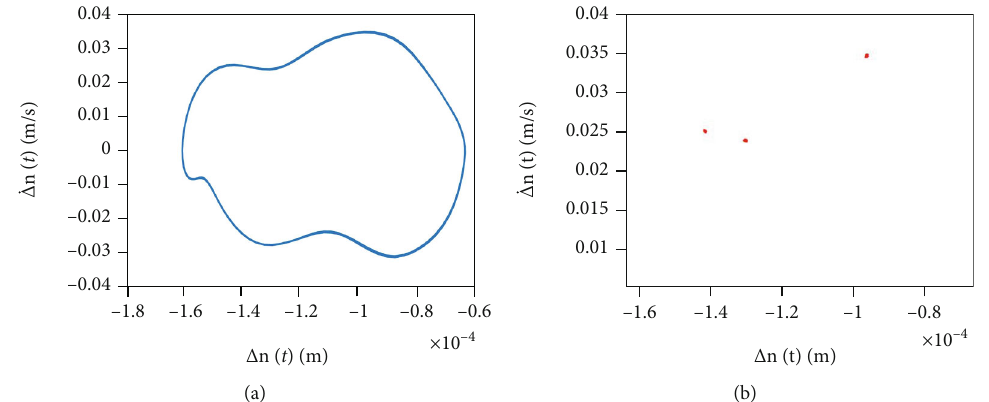
Figure 22: When the wear is 1 : 59 × 10 − 5 m (the misalignment in the x direction is 3 : 4 × 10 − 4 m): (a) relative displacement velocity and (b) the corresponding diagram of Poincare.